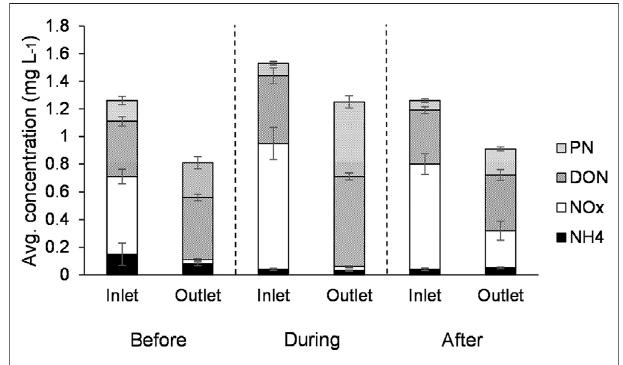
FIGURE 2 | Base fl ow average (SE) nitrogen concentration at the CW inlet and outlet, before, during and after maintenance.